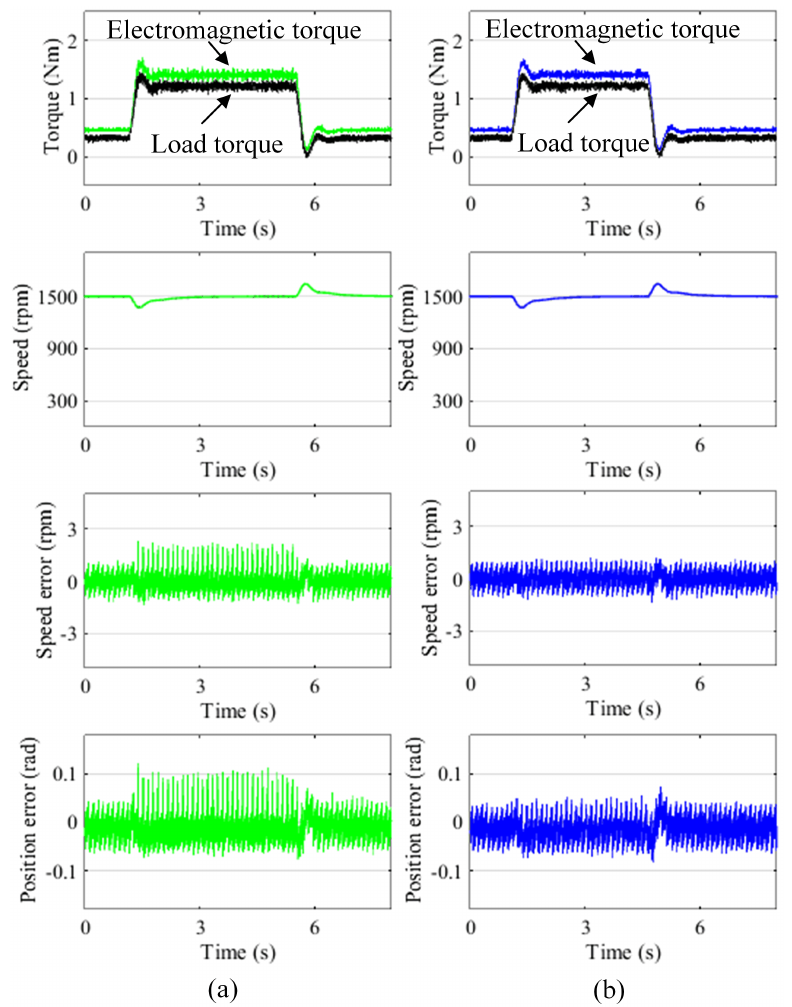
Figure 7. The load torque changes from 0.2 Nm (0.1 p.u.) to 1.2 Nm (0.6 p.u.): ( a ) conventional method; and ( b ) proposed method. “Black Line” means measured signals, “Green Line” represents the signals that are achieved by using convention method and “Blue Line” denotes the signals that are obtained by using the proposed